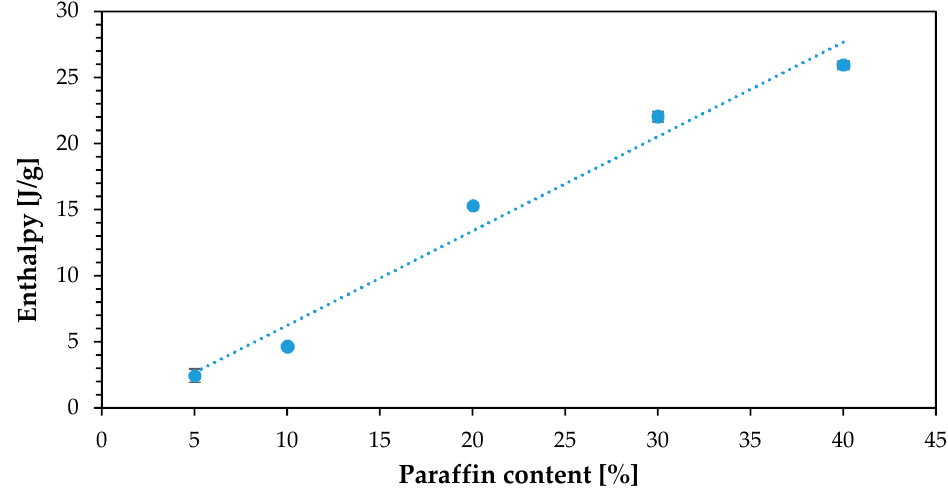
Figure 10. Enthalpy vs. paraffin content (all samples with 10% Cu).